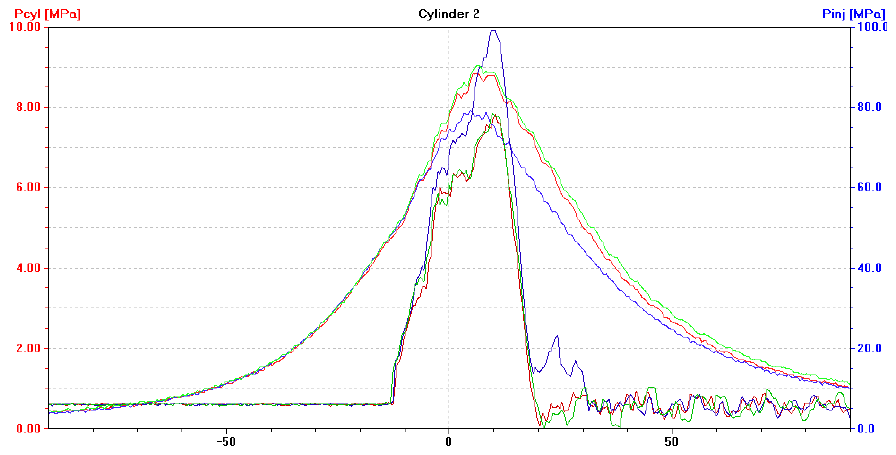
Figure 10. The diagram (screenshot of Unitest 2008) illustrates p cyl = f( α ) with the fuel injection characteristics of p inj = f( α ) for DEU with a defective ship engine-coked injector nozzle in the second cylinder, loaded at 70% MCR. Waveforms for cylinder: No. 1, No. 2, No. 3.